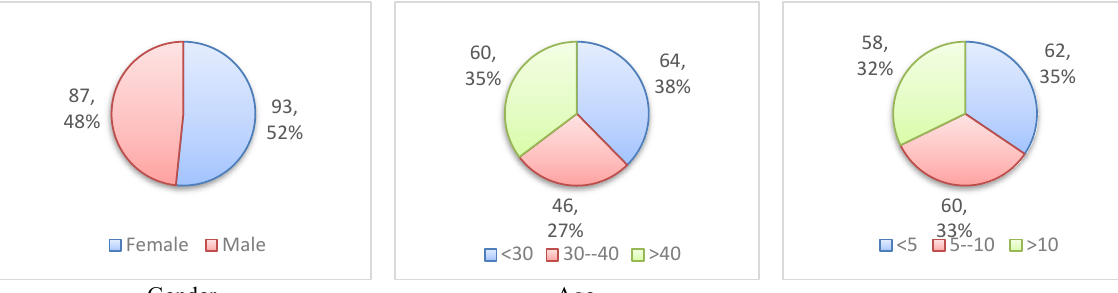
Fig. 2. Personal characteristics of the